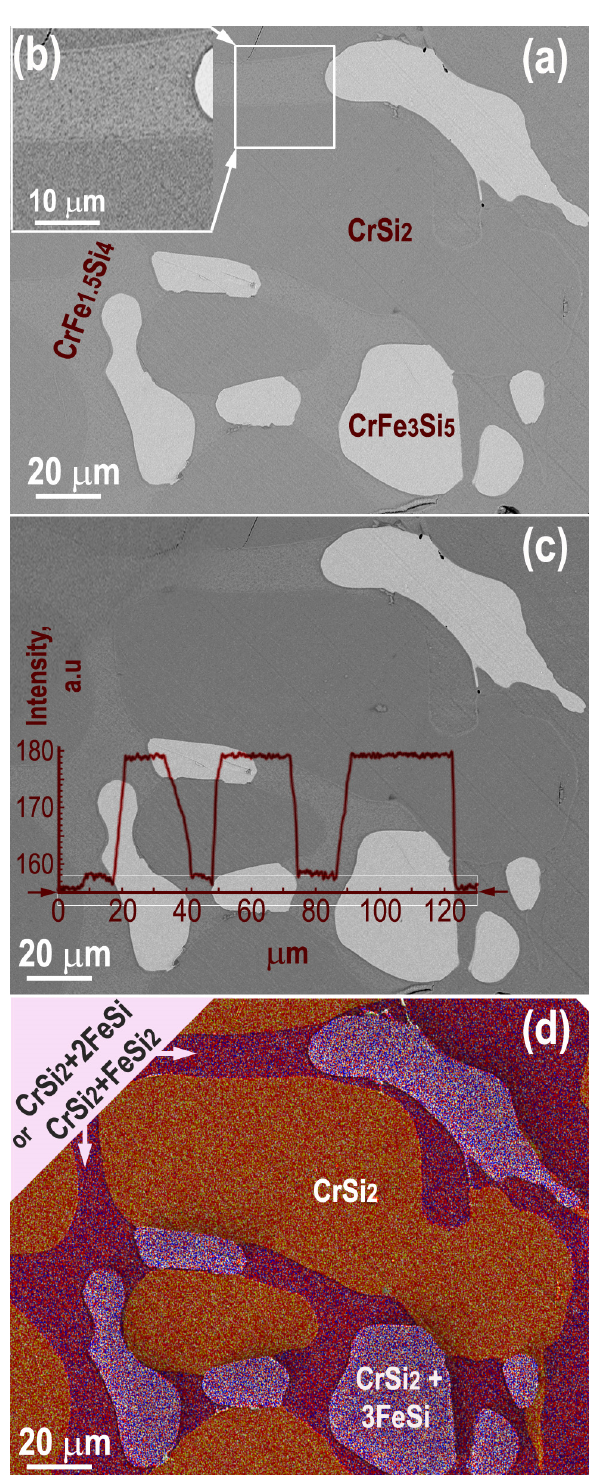
Figure 2. Non-annealed sample: BSE SEM image with grains of different chemical composition (based on EDXS analysis) CrSi 2 , CrFe 1.5 Si 4 and CrFe 3 Si 5 and thus responsible for the 3 different brightness levels ( a ); enlarged area of the selected rectangular area corresponding to an apparent chemical composition CrFe 1.5 Si 4 ( b ); BSE intensity line profile through grains of different effective atomic numbers due to their specific compositions ( c ), corresponding EDXS map with a mixture of Cr and Fe silicides that satisfies microanalysis data and BSE Z-contrast ( d